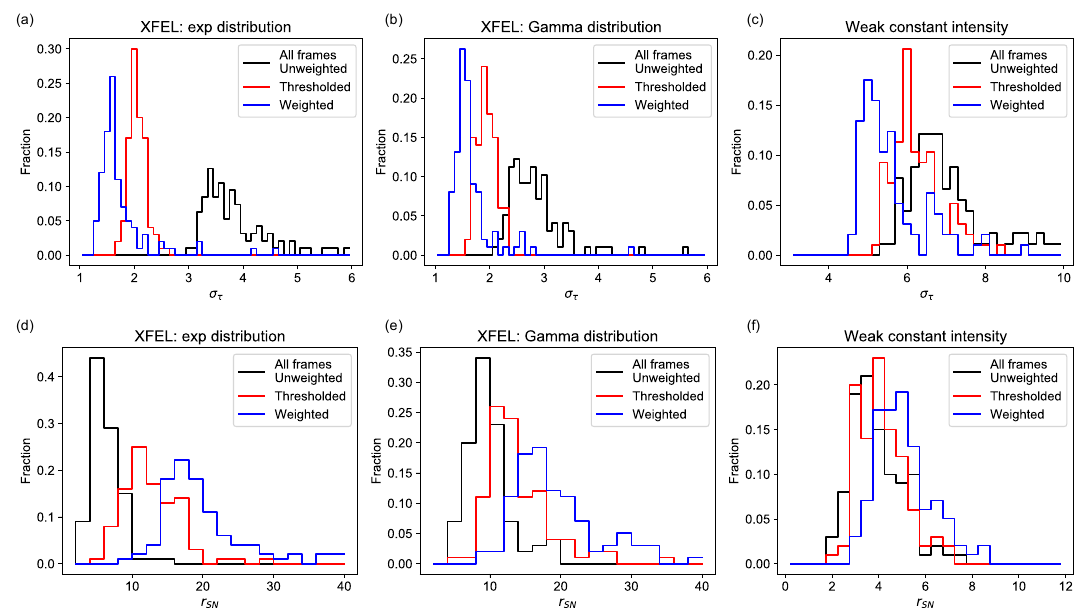
Figure 9. Comparing the thresholding vs. weighting approaches for different distributions of the incident X-ray intensities. The black, red and blue solid lines represent the histograms of ( a – c , top row ) r SN and ( d – f , bottom row ) σ τ by including all speckle frames, using the self-consistent thresholding and using the variance as the weighting factors, respectively. Each histogram is generated by running the simulation and X-ray photon correlation spectroscopy (XPCS) analysis 100